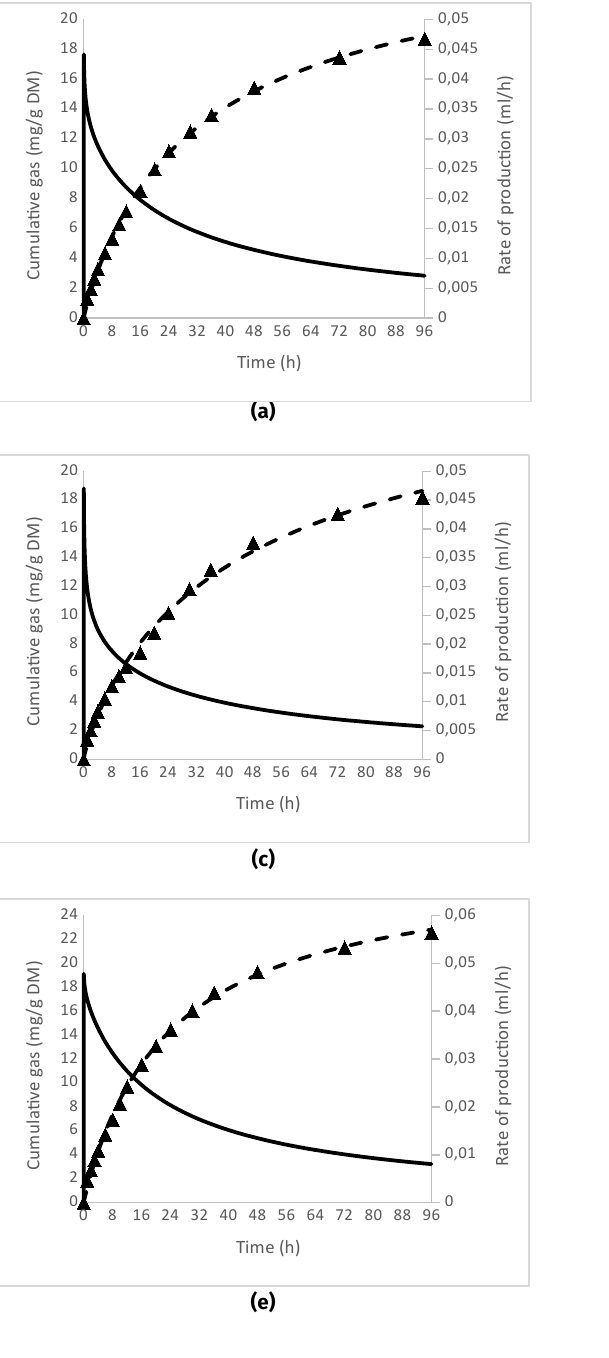
Figure 1. Cumulative gas production and rate of gas production profiles from pearl millet silage with different additives and ensiling methods. On panel (1a) Bag/CON; (1b) PVC/CON; (1c) Bag/Ground corn; (1d) PVC/Ground corn; (1e) Bag/ Lactobacillus plantarum (2.5 × 10 10 cfu/g) and Propionibacterium acidipropionici (2.5 × 10 10 cfu/g); and (1f) PVC/ Lactobacillus plantarum (2.5 × 10 10 cfu/g) and Propionibacterium acidipropionici (2.5 × 10 10